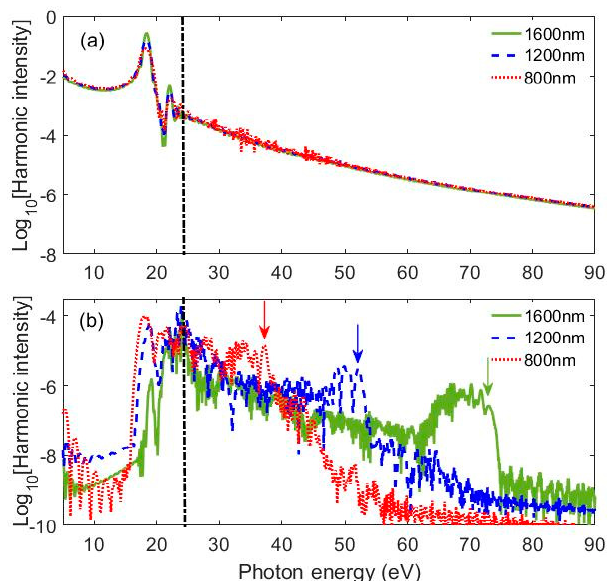
Figure 1. High-order harmonic spectra generated by a laser field with a constant amplitude ( a ) and with a sine-squared envelope ( b ). Three different wavelengths are considered. The interaction time between He atom and the laser field is 10 optical cycles and the laser intensity is 1.0 × 10 14 W/cm 2 .